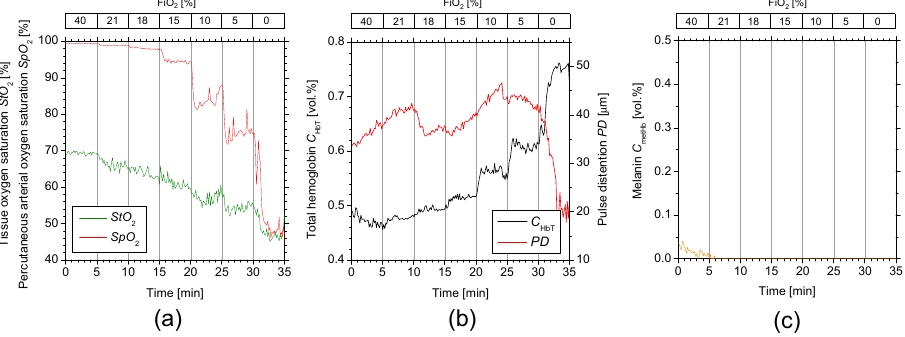
Figure 9. Typical time courses of ( a ) StO 2 , ( b ) C HbT , and ( c ) C metHb averaged over entire region of each corresponding image shown in Figure 8. Time courses of SpO 2 and PD were also compared with StO 2 and C HbT , respectively. Figure 10 shows scatter plots of (a) ∆ SpO 2 vs. ∆ StO 2 and (b) ∆ C HbT vs. ∆ PD obtained from the three rats. As can be seen, the values of ∆ StO 2 and ∆ C HbT correlated with those of SpO 2 and ∆ PD , respectively. The correlation coefficient between ∆ SpO 2 and ∆ StO 2 and that between ∆ C HbT and ∆ PD were R = 0.48 ( p < 0.0001) and R = 0.73 ( p < 0.0001), indicating that StO 2 and C HbT were moderately correlated with SpO 2 and PD ,